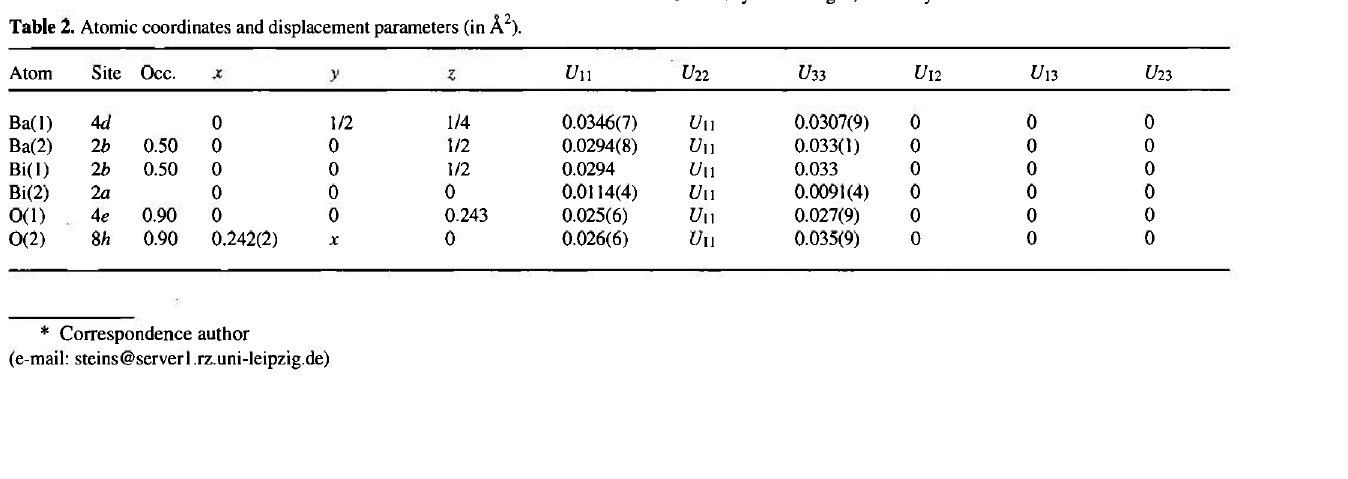
Table 2. Atomic coordinates and displacement parameters (in A 2 ).